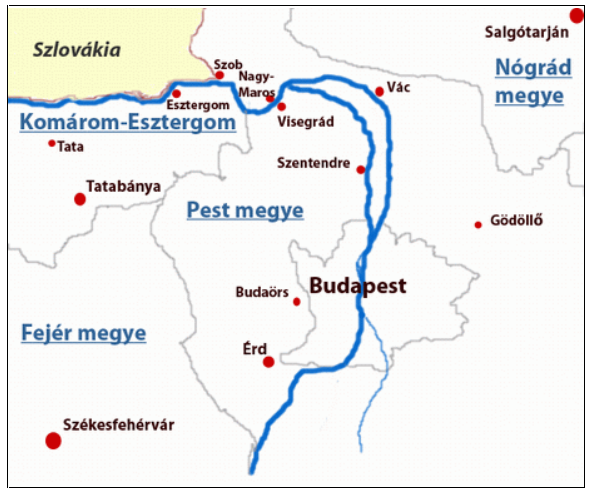
Fig. 1. Danube-bend Region in Pest